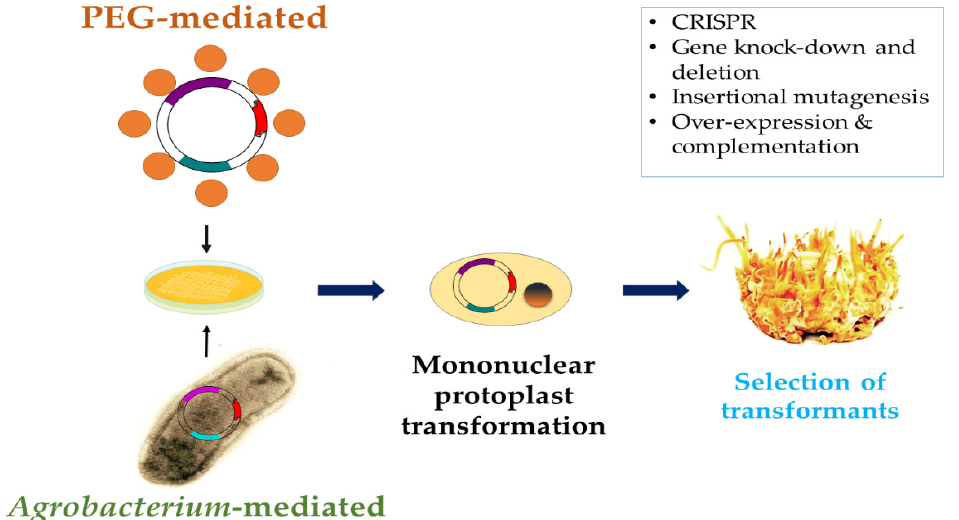
Figure 2. Schematic overview of genetic engineering approaches commonly used in C. militaris .